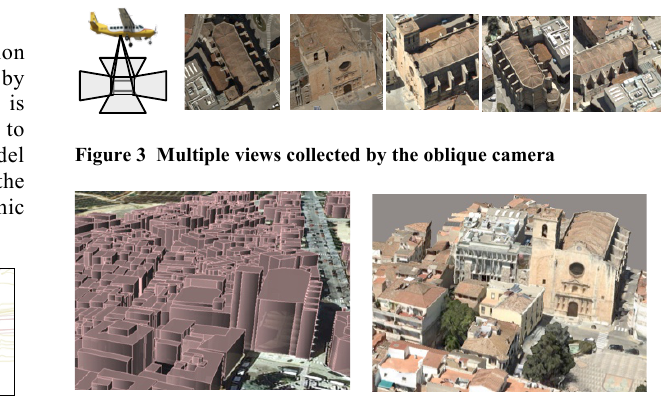
Figure 4 Current LoD1 model without textures and the LoD2 model texturized using oblique images